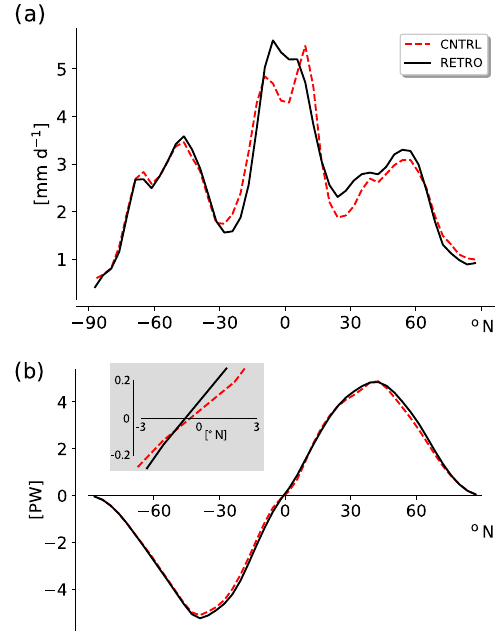
Figure 7. Zonally and annually averaged (a) precipitation, and (b) atmospheric energy flux for RETRO (black, solid) and CNTRL (red, dashed). The inset in panel (b) shows the atmospheric energy flux (computed as the integral of the vertical heat flux convergence as a function of latitude) in the vicinity of the zero crossing near the